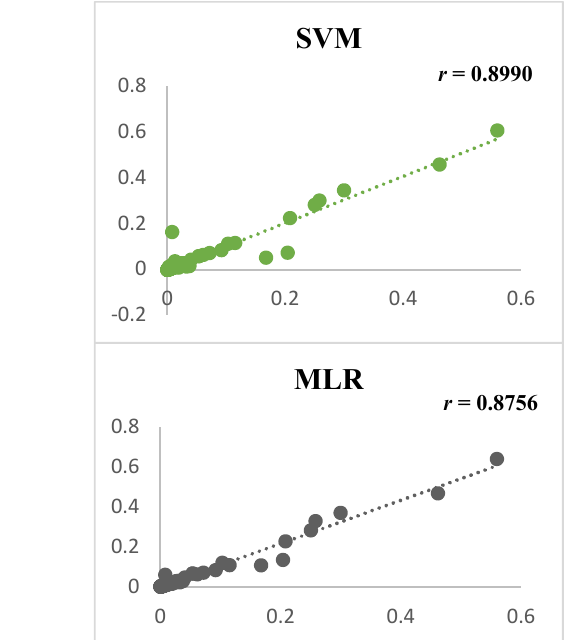
Table 5. The ensemble approach used to model COVID-19 mortality.